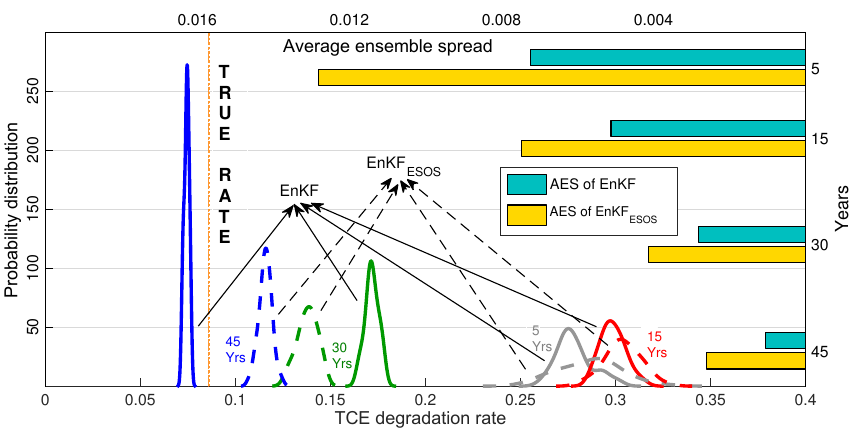
Figure 14. Left y axis: the time evolution of the prior probability density functions corresponding to TCE degradation rate obtained using the EnKF (solid lines) and the EnKF ESOS (dashed lines). The reference “true” rate is given at 0.086day − 1 in brown color. Right y axis: the AES of K T suggested using the EnKF and the EnKF ESOS